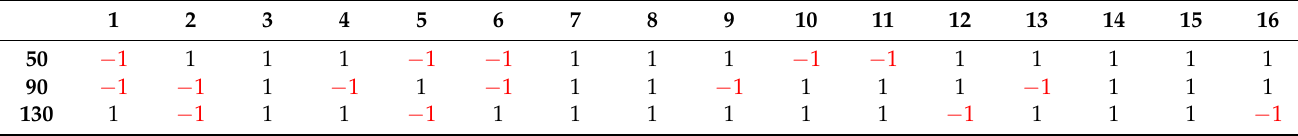
Table 7. The level of cognitive load based on pupil diameter: T ≥ B → 1; T < B → − 1 (red).